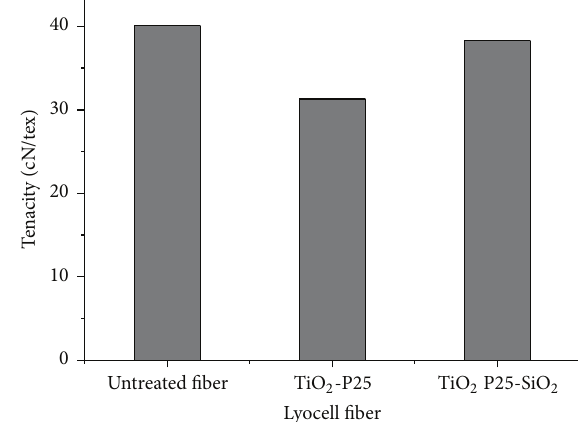
Figure 7: Mechanical properties of untreated, TiO 2 treated, and TiO 2 -SiO 2 treated fibers [51].